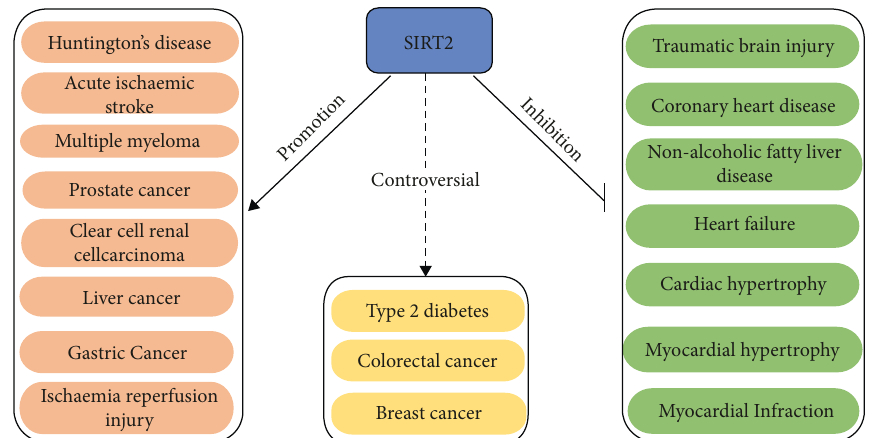
Figure 3: The role of SIRT2 in various metabolic disorders. SIRT2 promotes the progression of Huntington’s disease, acute ischaemic stroke, multiple myeloma, prostate cancer, clear-cell renal cell carcinoma, liver cancer, gastric cancer, and ischaemia reperfusion injury. SIRT2 inhibits the progression of traumatic brain injury coronary heart disease, nonalcoholic fatty liver disease, heart failure, cardiac hypertrophy, myocardial hypertrophy, and myocardial infarction. The role of SIRT2 in type 2 diabetes, colorectal cancer, and breast cancer remains